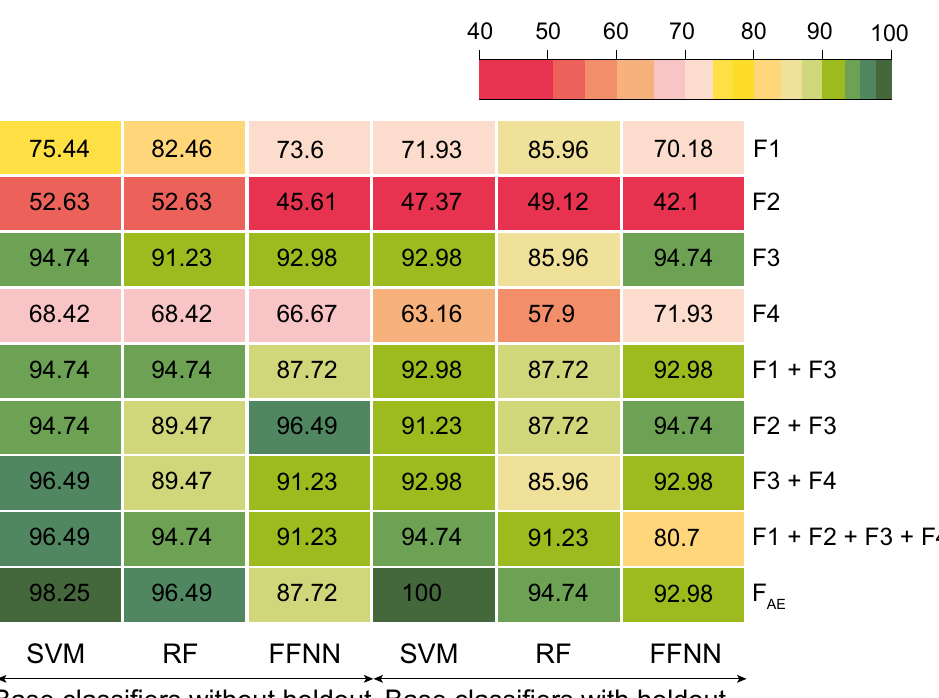
Figure 5. Classification accuracy of different base classifiers tested on different omic-levels and their combinations (F1: mRNA (PcGs) expression, F2: miRNA expression, F3: DNA methylation, F4: protein expression, F AE : features from bottleneck layer of autoencoder, SVM: support vector machine, RF: random forest, FFNN: feed-forward neural network).